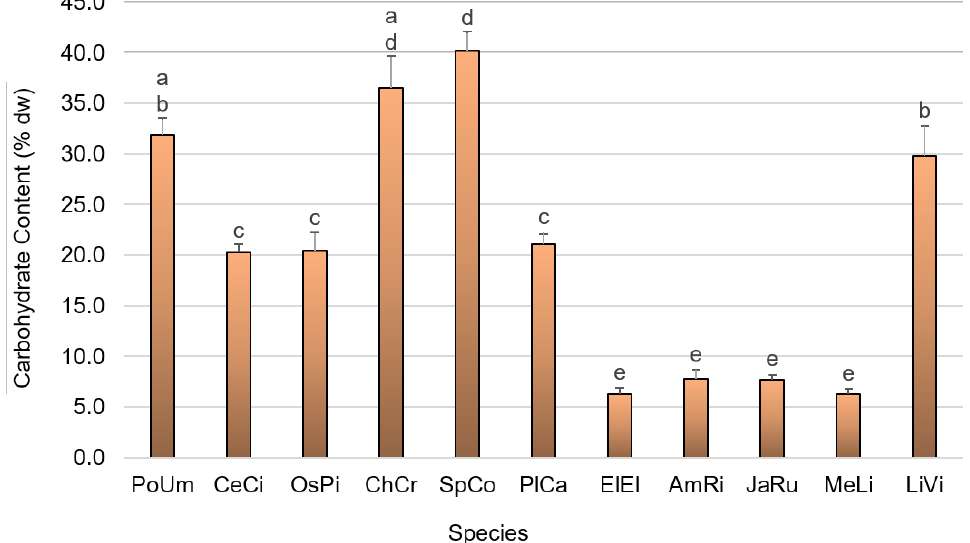
Figure 5. Carbohydrate content of the eleven studied red seaweed species expressed in % of dry weight. PoUm: Porphyra umbilicalis , CeCi: Ceramium ciliatum , OsPi: Osmundea pinnatifida , ChCr: Chondrus crispus , SpCo: Sphaerococcus coronopifolius , PlCa: Plocamium cartilagineum , ElEl: Elisolandia elongata , AmRi: Amphiroa rigida , JaRu: Jania rubens , MeLi: Mesophyllum lichenoides , LiVi: Liagora viscida . Values are presented as means ± SD ( n = 3), and lower-case letters ( a to e ) indicate statistically significant differences in the Tukey HSD test (F(10,32) = 170.637; p = 0.00).